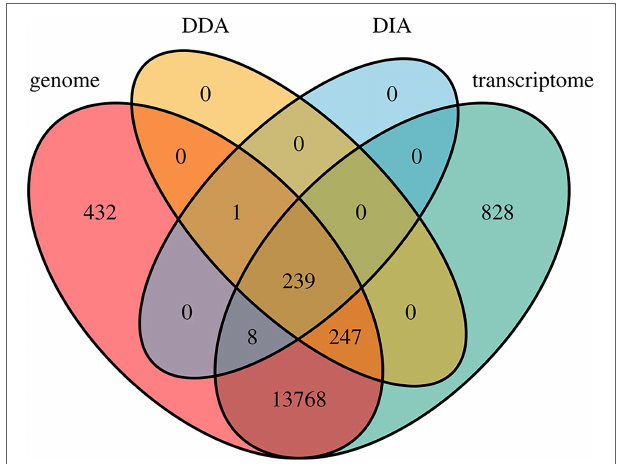
FIGURE 7 | A Venn diagram of AHTP-derived genes from the genome, transcriptome, and proteome (both DIA and DDA modes) datasets.